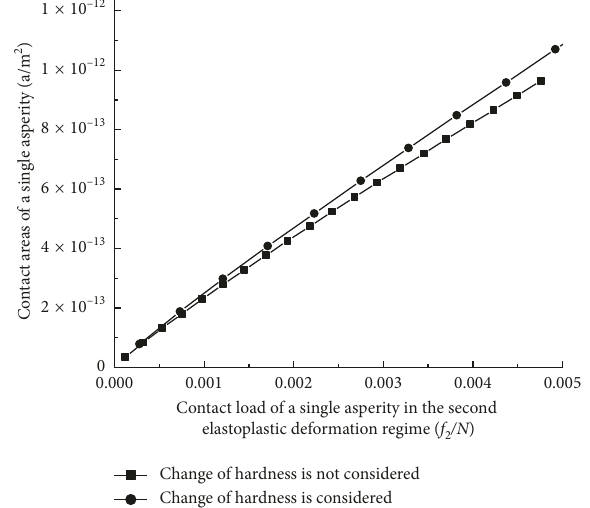
Figure 5: The relationship between contact load and contact area of single asperity in the second elastoplastic deformation